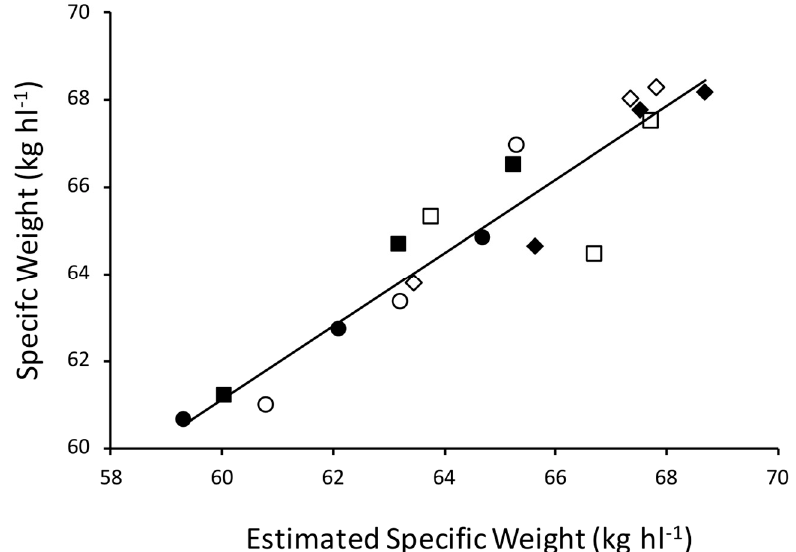
Figure 4. Specific weight of 18 barley grain samples plotted against the product of packing efficiency and grain density. The linear relationship is shown by the solid black line which has the equation, y = 0.84x + 10.15 (r = 0.94, p < 0.001). Solid shapes are well-watered, and open shapes are from water-stressed plants. Squares = Concerto, diamonds = Sienna and circles = Octavia.